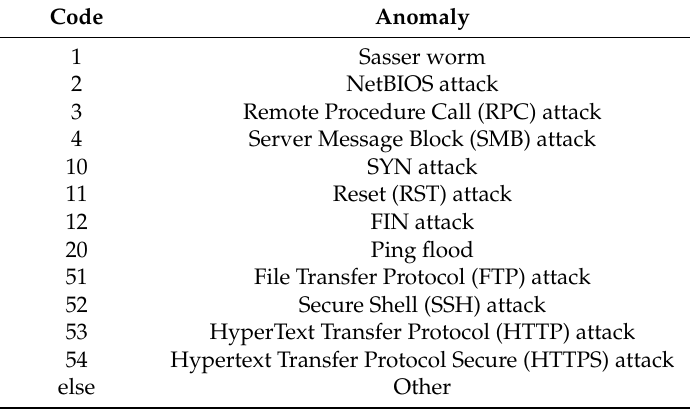
Table 1. Anomalies with a code value below 500.